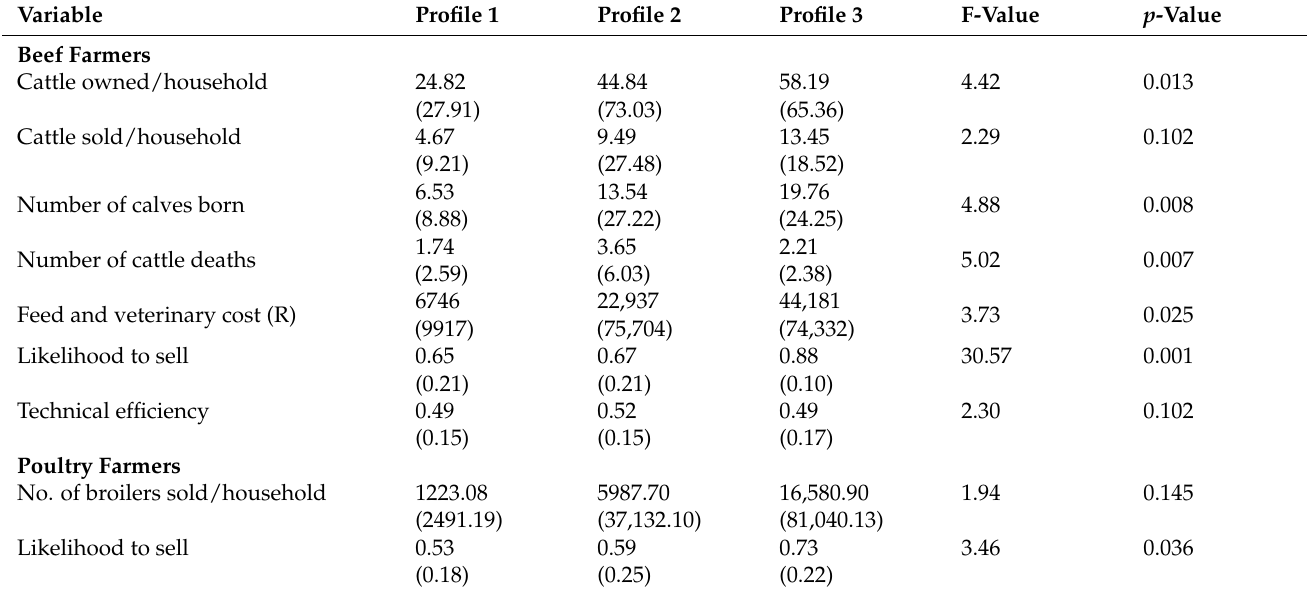
Table 7. Selected performance indicator by different farmers’